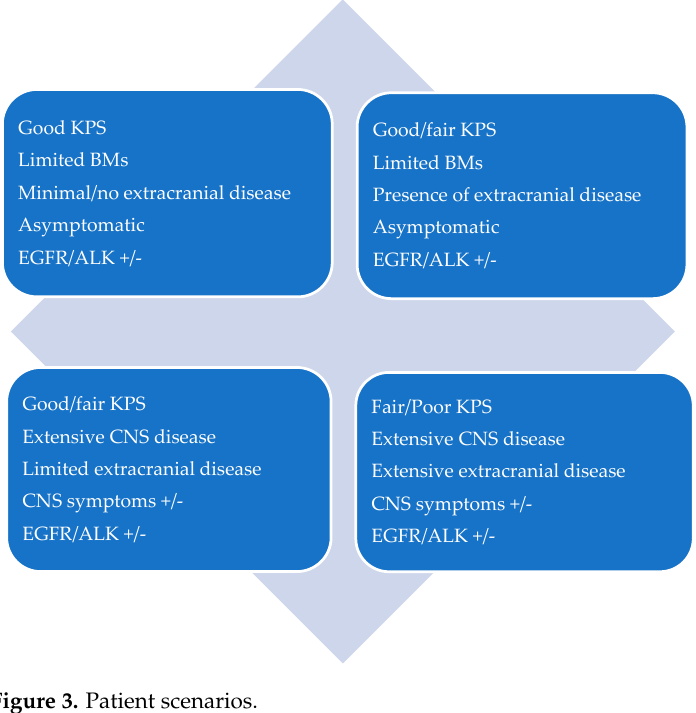
Figure 3. Patient scenarios.